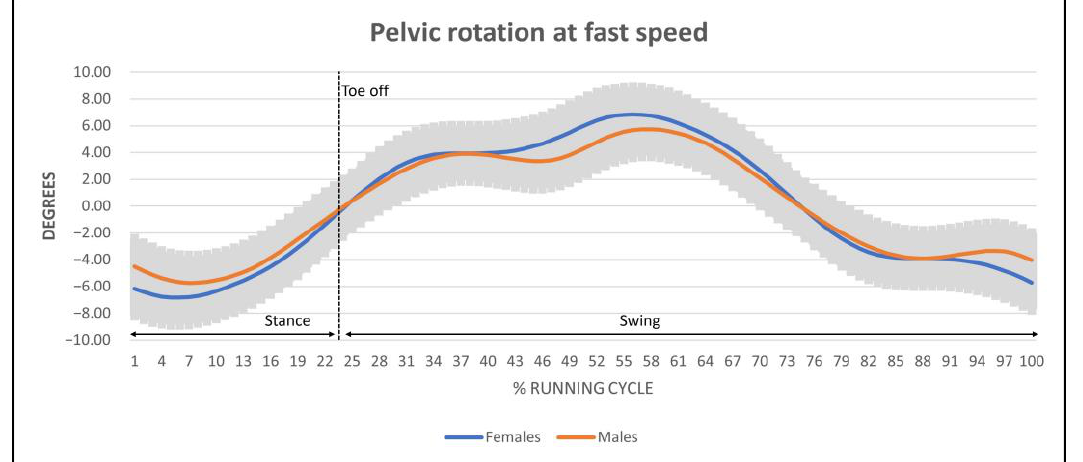
Figure 4. Pelvic rotation traces with mean amplitude regarding the fast speed. Negative degrees represent external rotation of the pelvis, while positive degrees represent internal rotation.